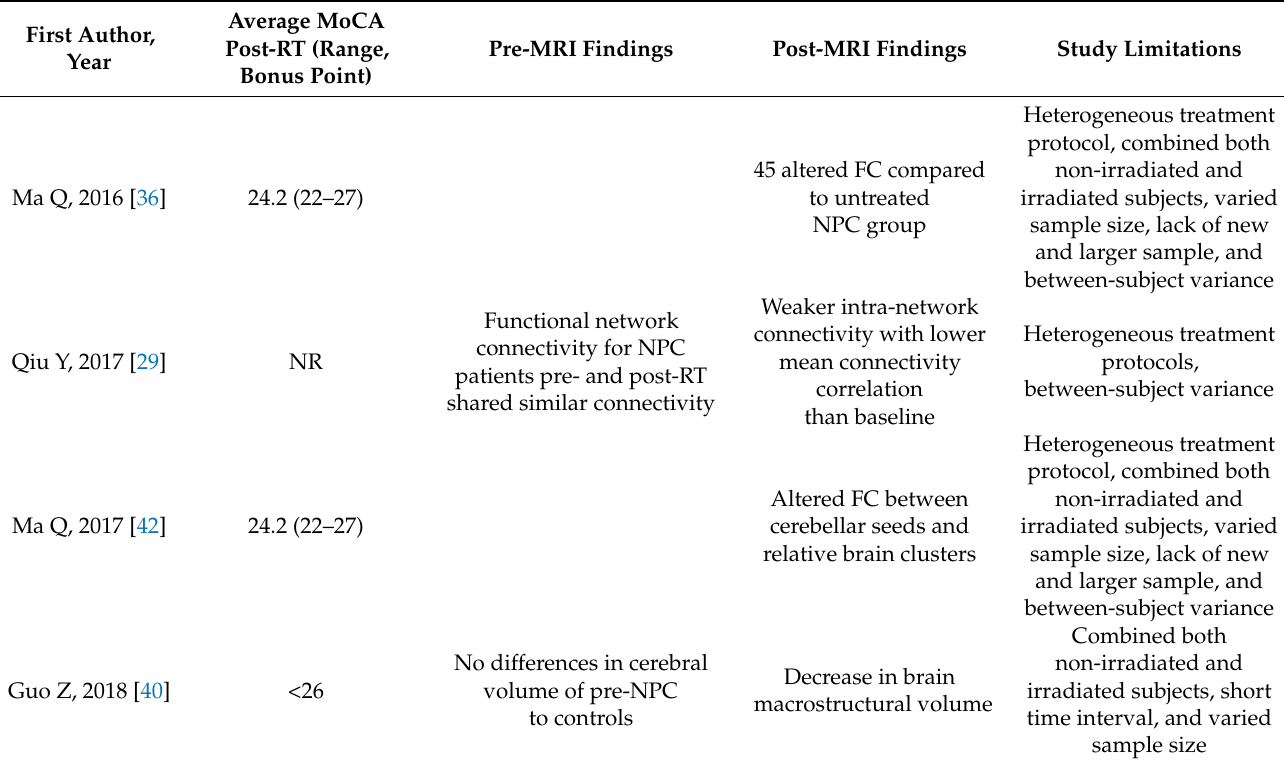
Table 2. MoCA scores and changes in MRI